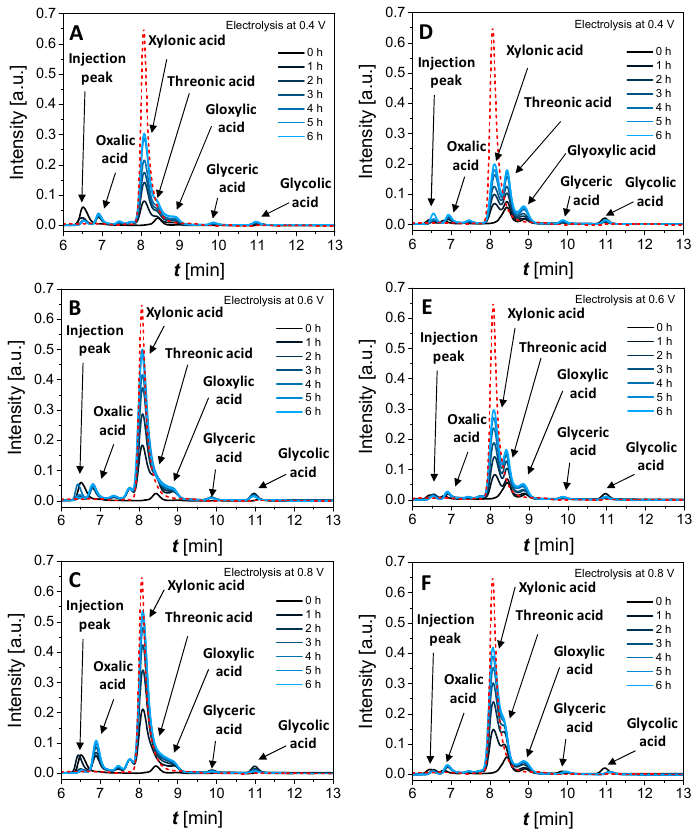
Figure 9. Chromatograms recorded as a function of time (every hour from 0 to 6 h chronoamperometry) for the electro-reforming in 0.10 mol L − 1 NaOH solution of ( A ) 0.10 mol L − 1 xylose at + 0.4 V, ( B ) 0.10 mol L − 1 xylose at + 0.6 V, ( C ) 0.10 mol L − 1 xylose at + 0.8 V, ( D ) 0.50 mol L − 1 xylose at + 0.4 V, ( E ) 0.50 mol L − 1 xylose at + 0.6 V and ( F ) 0.50 mol L − 1 xylose at + 0.8 V. The lithium xylonate standard (0.1 mol L − 1 ) is presented in red.